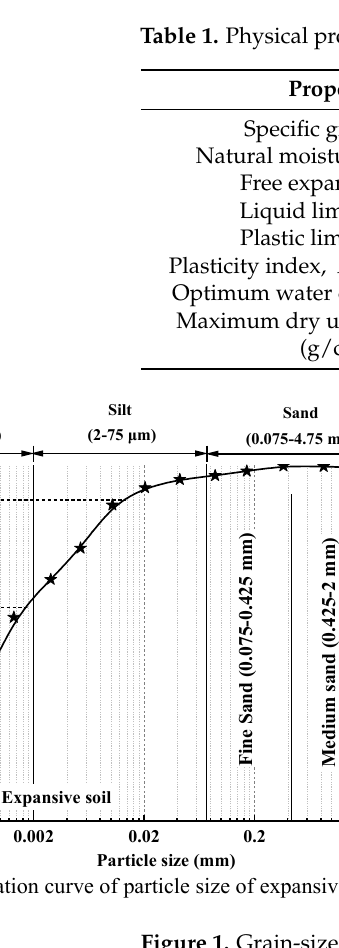
Figure 1. Grain-size distribution curves ( a ) and compaction test ( b ) for the soil. Table 1. Physical properties of the selected expansive soil.